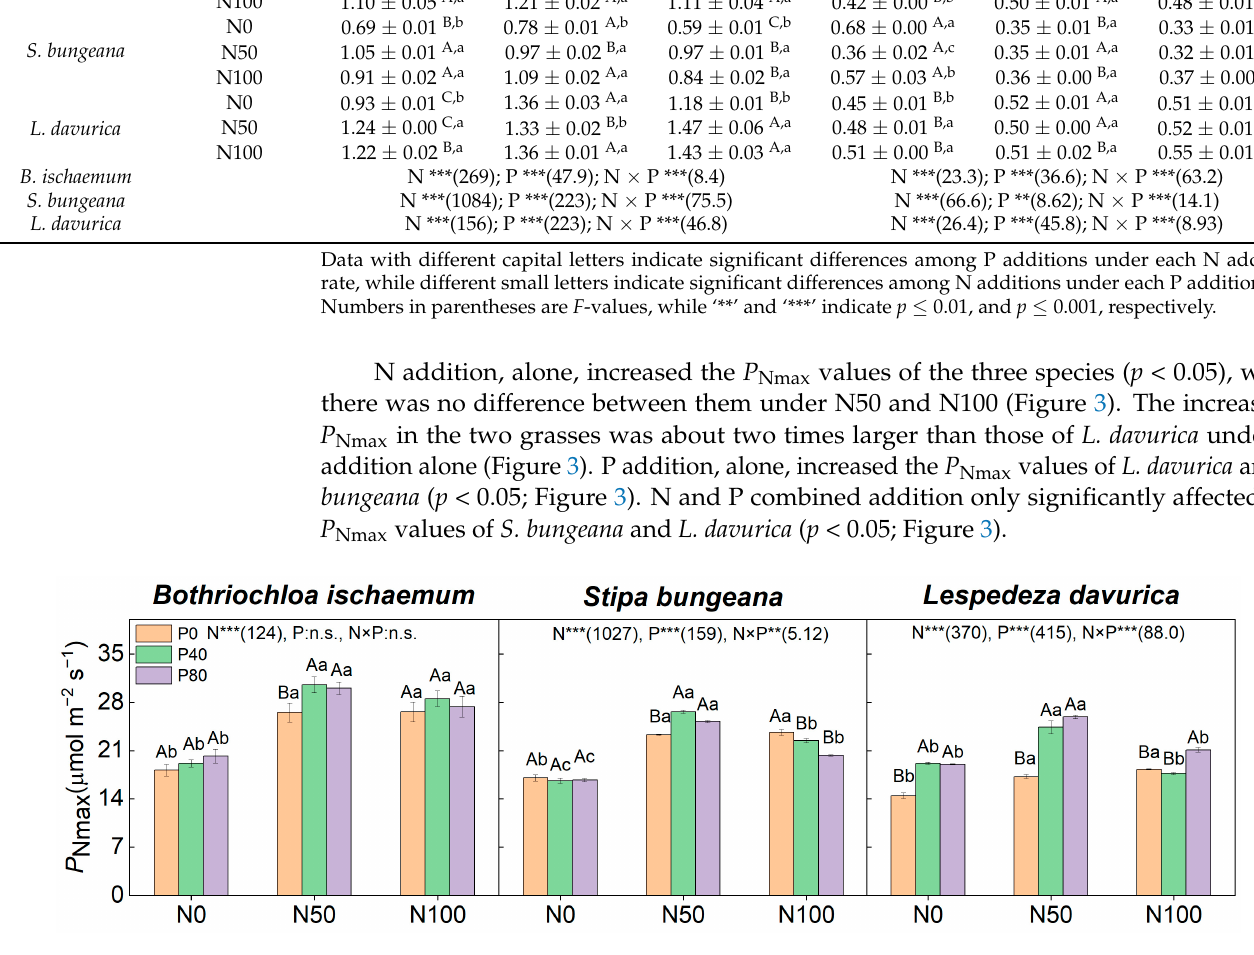
Figure 3. Leaf maximum net photosynthetic rate ( P Nmax ) of the three species under different N and P addition treatments. Values are mean ± SD. Different capital letters above the column indicate significant differences among P additions under each N addition rate, while different small letters indicate significant differences among N additions under each P addition rate. Numbers in parentheses are F -values, while ‘**’, and ‘***’ indicate p ≤ 0.01, and p ≤ 0.001, respectively. ‘n.s.’ indicates no significant